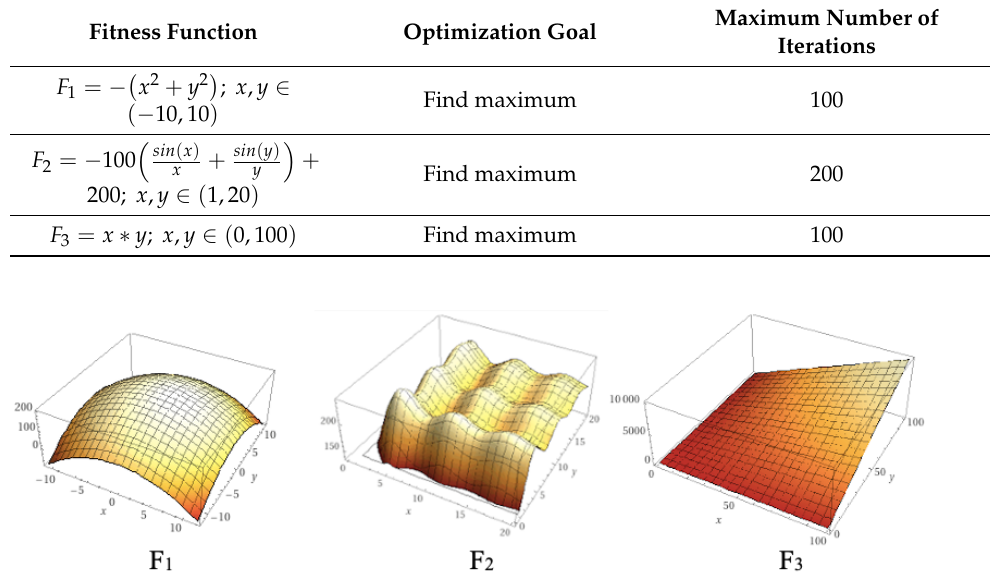
Table 6. The functions used for testing the performance.